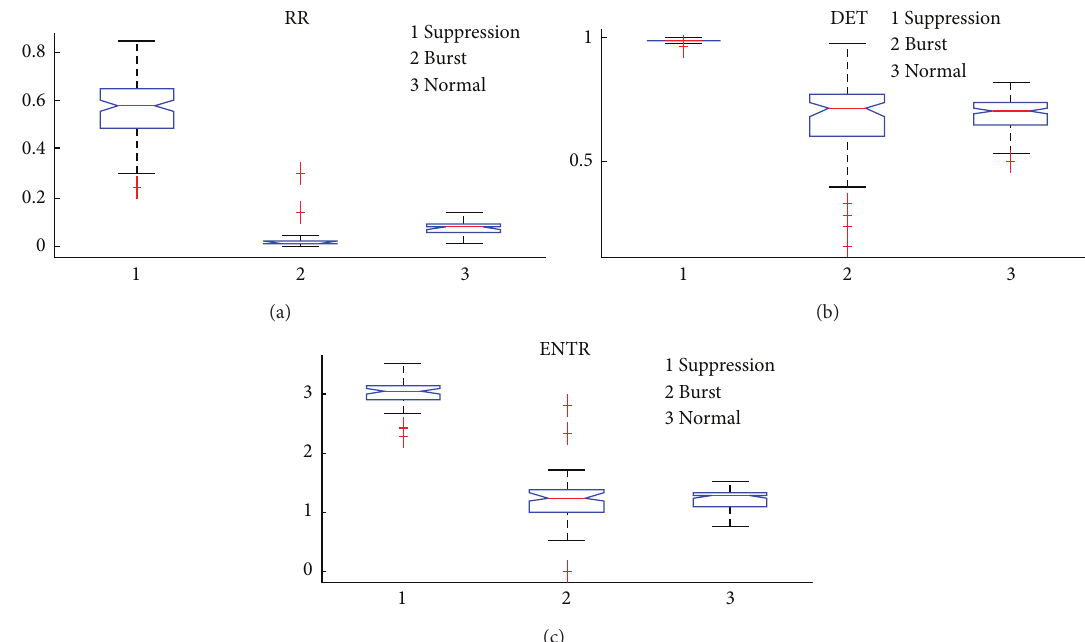
Figure 5: The boxplot of three different indexes at the burst suppression normal states. (a) The RR index, (b) The DET index. (c) The ENTR